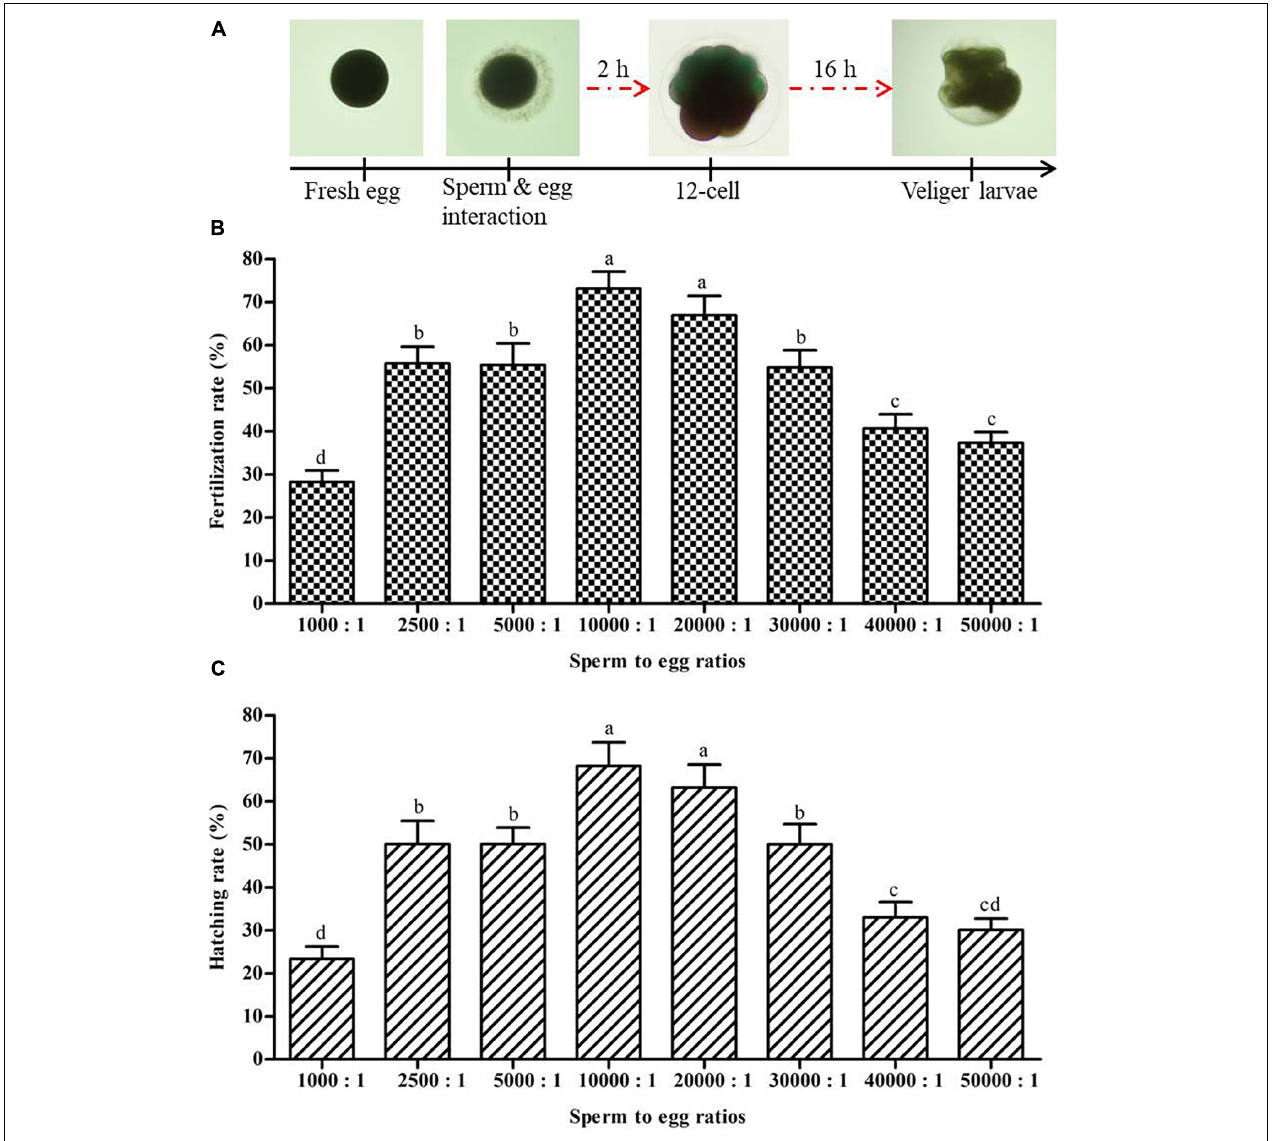
FIGURE 8 | Determination of suitable sperm to egg ratio for in vitro fertility and hatchability of Pacific abalone, H. discus hannai . (A) Twelve-cell division occurred at 2 h after fertilization and Veliger larvae formed at 16 h after fertilization. (B) Effects of different ratios of sperm to egg on fertilization rate ( n = 3). (C) Effects of different ratios of sperm to egg on hatching rate ( n = 3). Different superscript letters (a–d) above bars indicate significant ( p < 0.05) differences between different